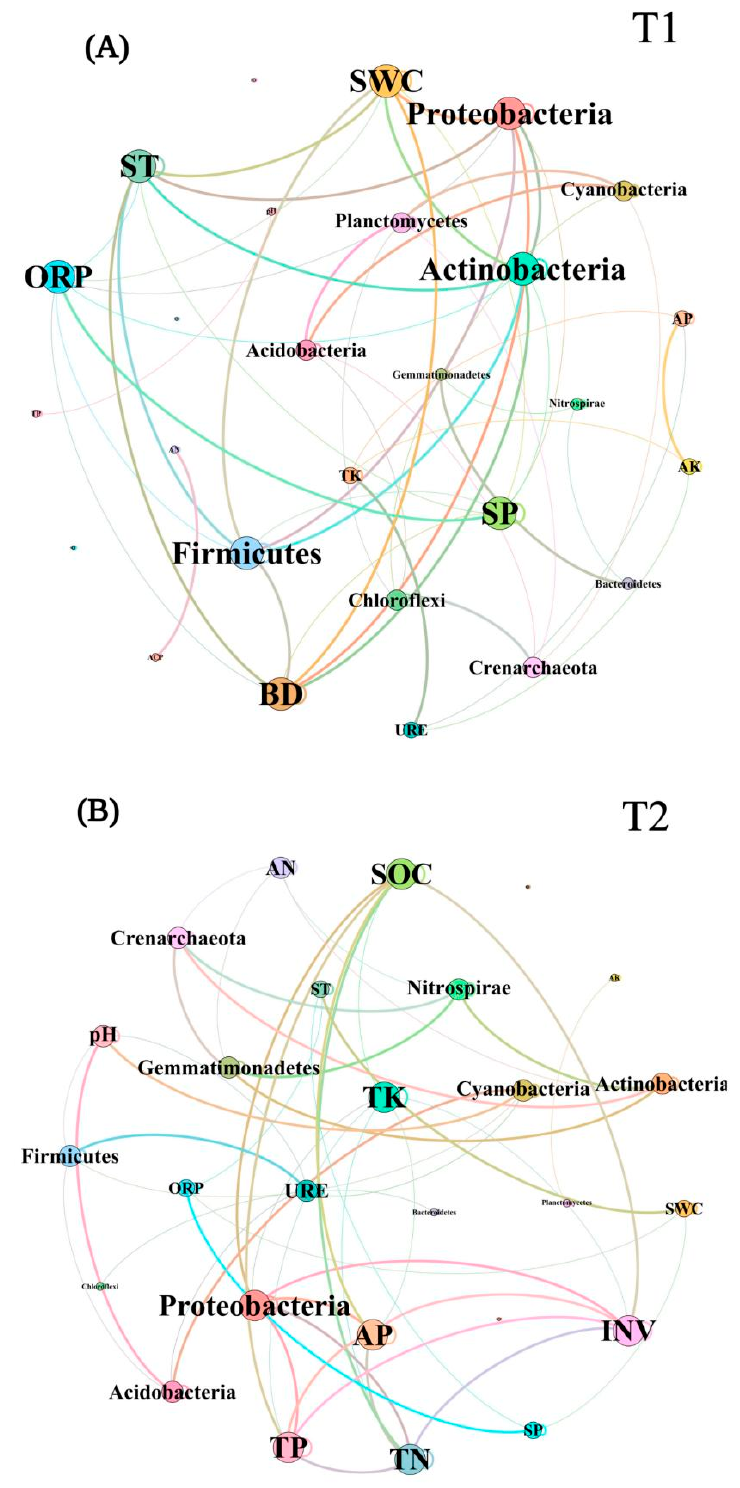
dance in ( A ), and among soil physical properties, soil enzyme activities, and bacterial community abundance in ( B ). Circle size and color shade represent the correlation analysis value magnitude and direction. Blue and red represent positive and negative correlations. (The bottom left corner of the figure is T2, and the top right corner is T1). Significant at p < 0.001 (***) or p < 0.01 (**) or p < 0.05 (*).